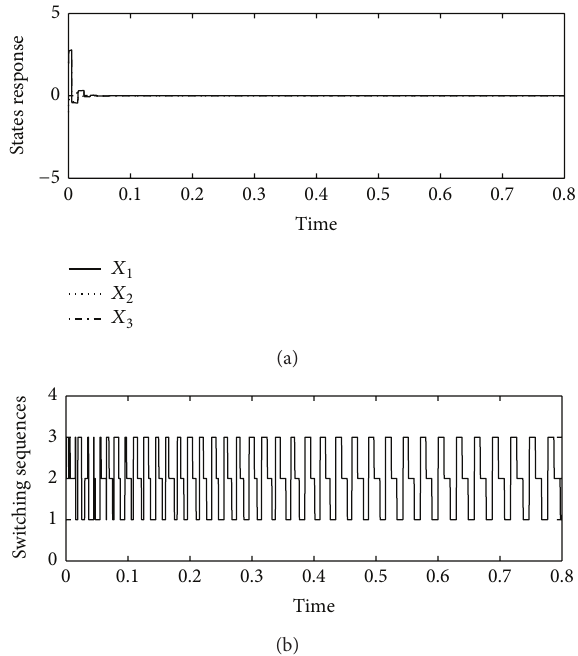
Figure 4: (a) Timing response of three states and (b) switching sequences.